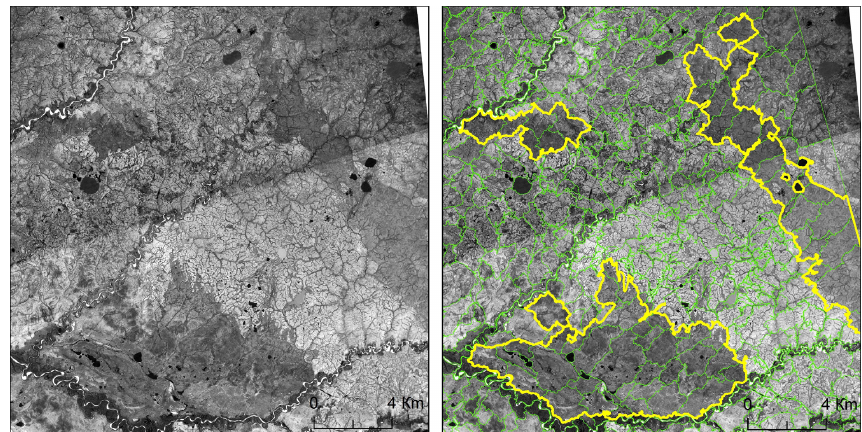
Figure 2. An example of segmentation and classification of burned areas in Corona mosaic. Left panel: original mosaic. Right panel: mosaic after segmentation and classification. Green curves – boundaries of segments, yellow curves – boundaries of identified burned areas.